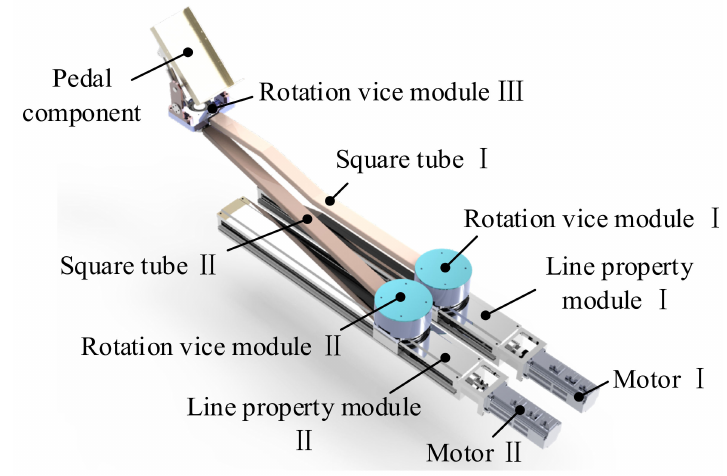
Figure 4. Lower limb rehabilitation training component.